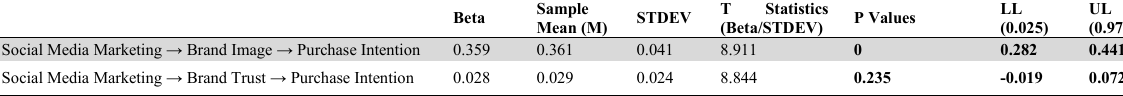
The results of some basic statistics and indirect path coefficients